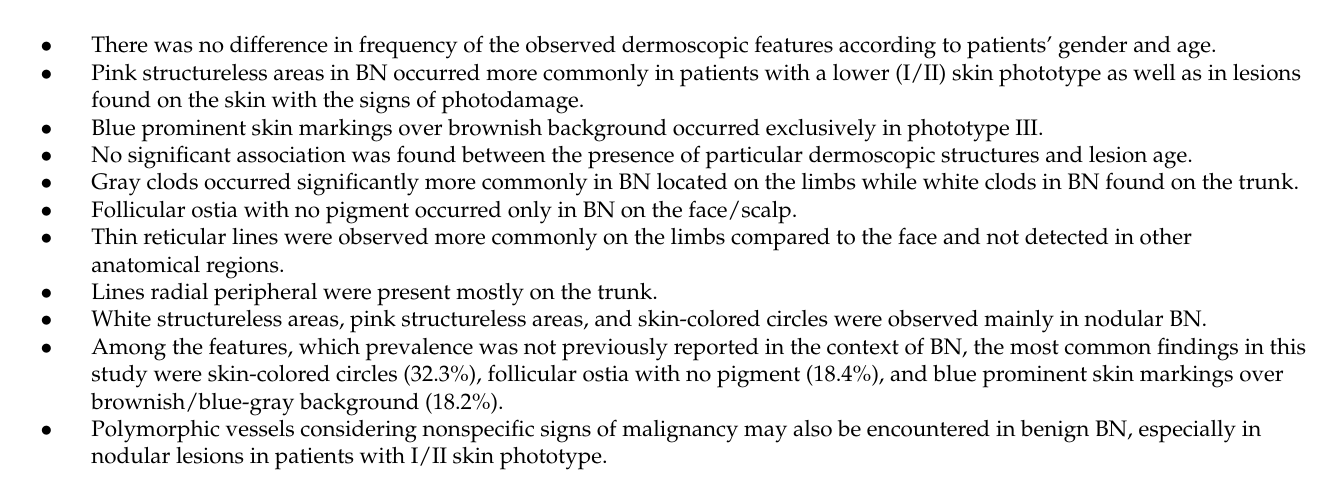
Table 3. Key observations from the